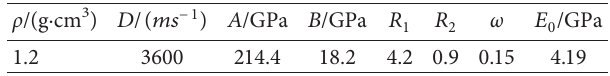
Table 5: Parameters of the explosive and the JWL equation of